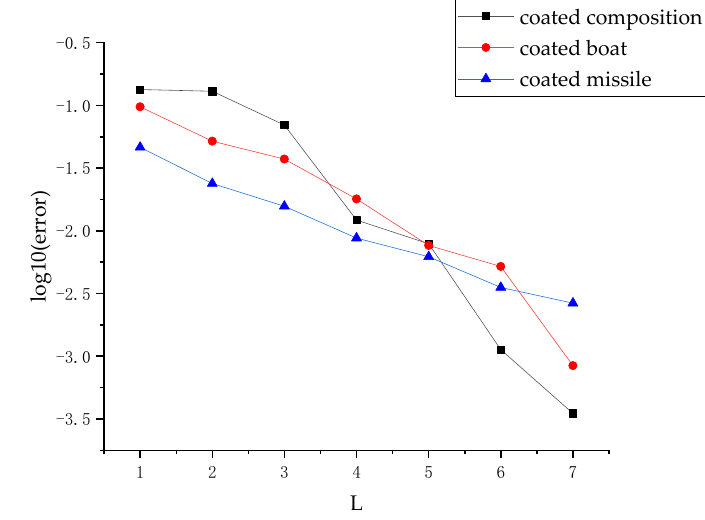
Figure 17. Convergence curves for order L.